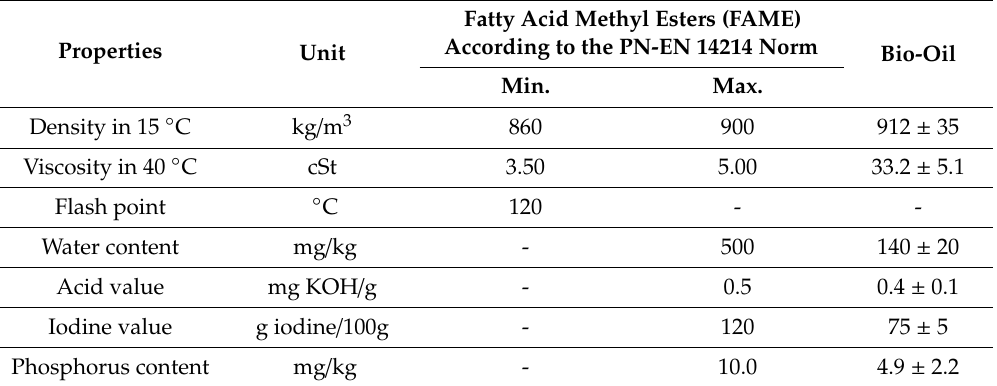
Table 5. The fuel properties of the bio-oil obtained from the microalgae biomass.